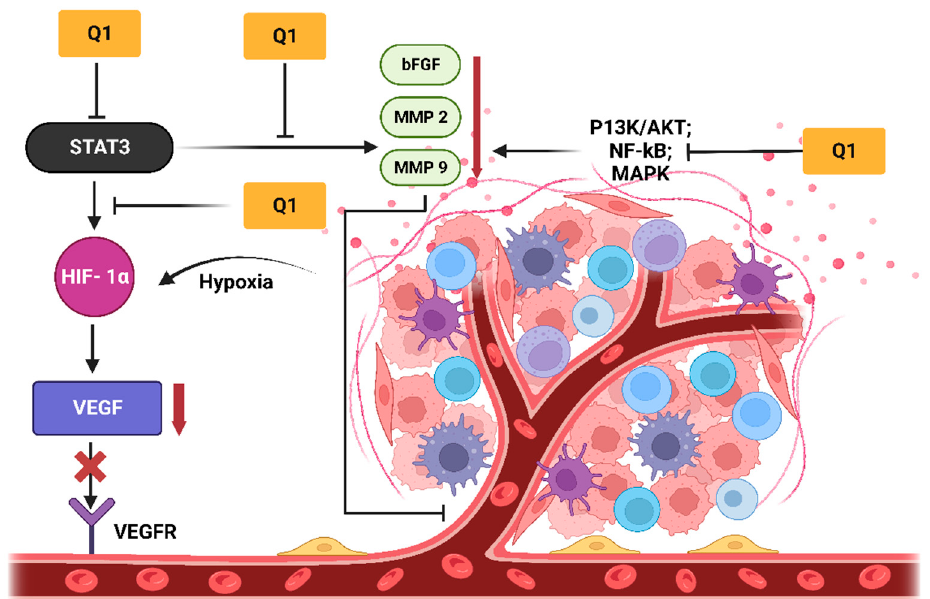
Figure 4. Anti-angiogenesis effects: quercetin (Q1) significantly inhibits the activation of VEGF by downregulating signaling molecules such as AKT and NF-kB, demonstrating the direct inhibition of VEGFR on the surface of endothelial cells. Additionally, the inhibition of the JAK- STAT3 pathway exerted anti-inflammatory and antitumor activities through the downregulation of MMP 2, MMP 9, TNF- α and bFGF. The inhibition of these factors retarded angiogenesis. VEGF and bFGF are two crucial factors in angiogenesis that upregulate the proliferation, migration, and formation of endothelial cells. The diagram was adopted with modifications from Asma et al. [30]. Created with Biorender.com (accessed on 10 April